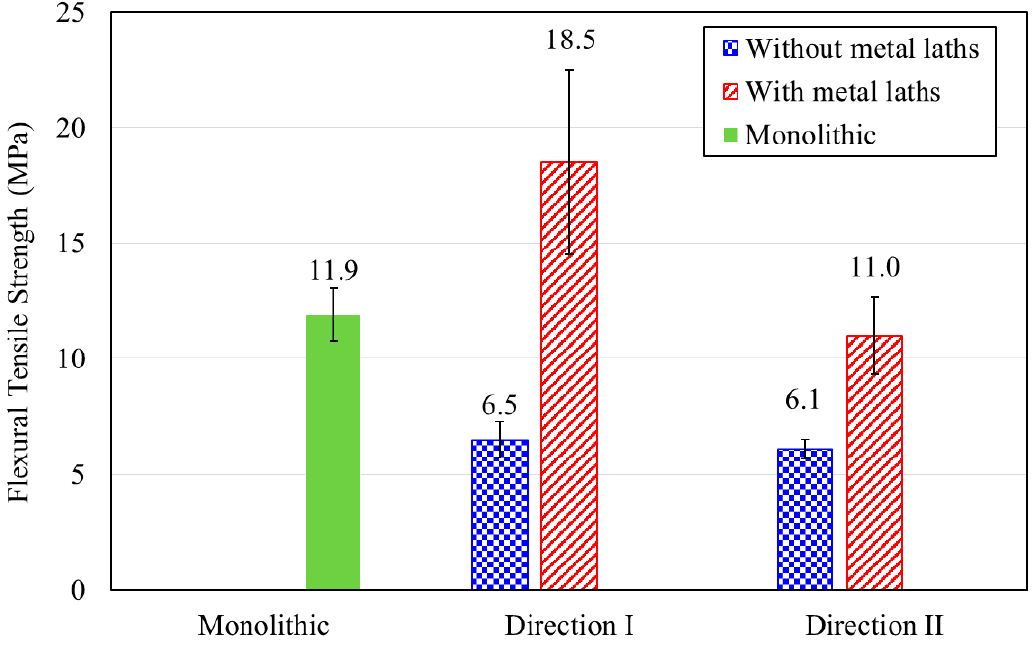
Figure 12. Flexural tensile test results.